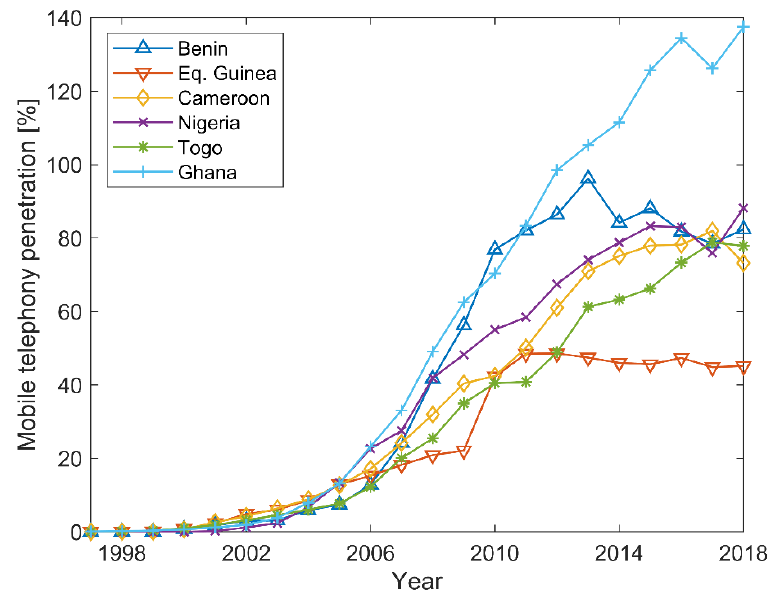
Figure 3. Mobile telephony penetration in the Gulf of Guinea (based on data available from [27]).